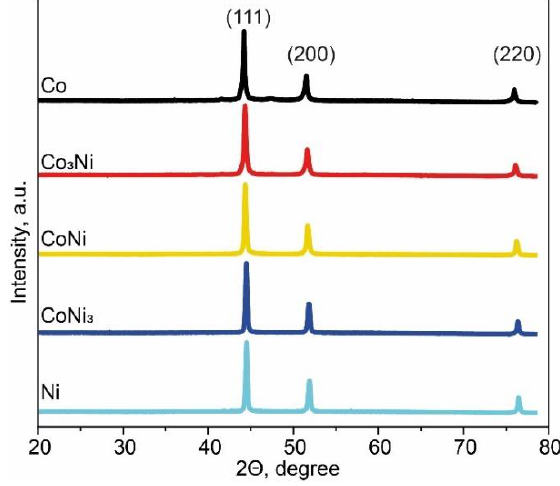
Figure 1. XRD patterns of the catalyst powders synthesized by SGCS. Table 1. Structure characteristics of the catalysts.